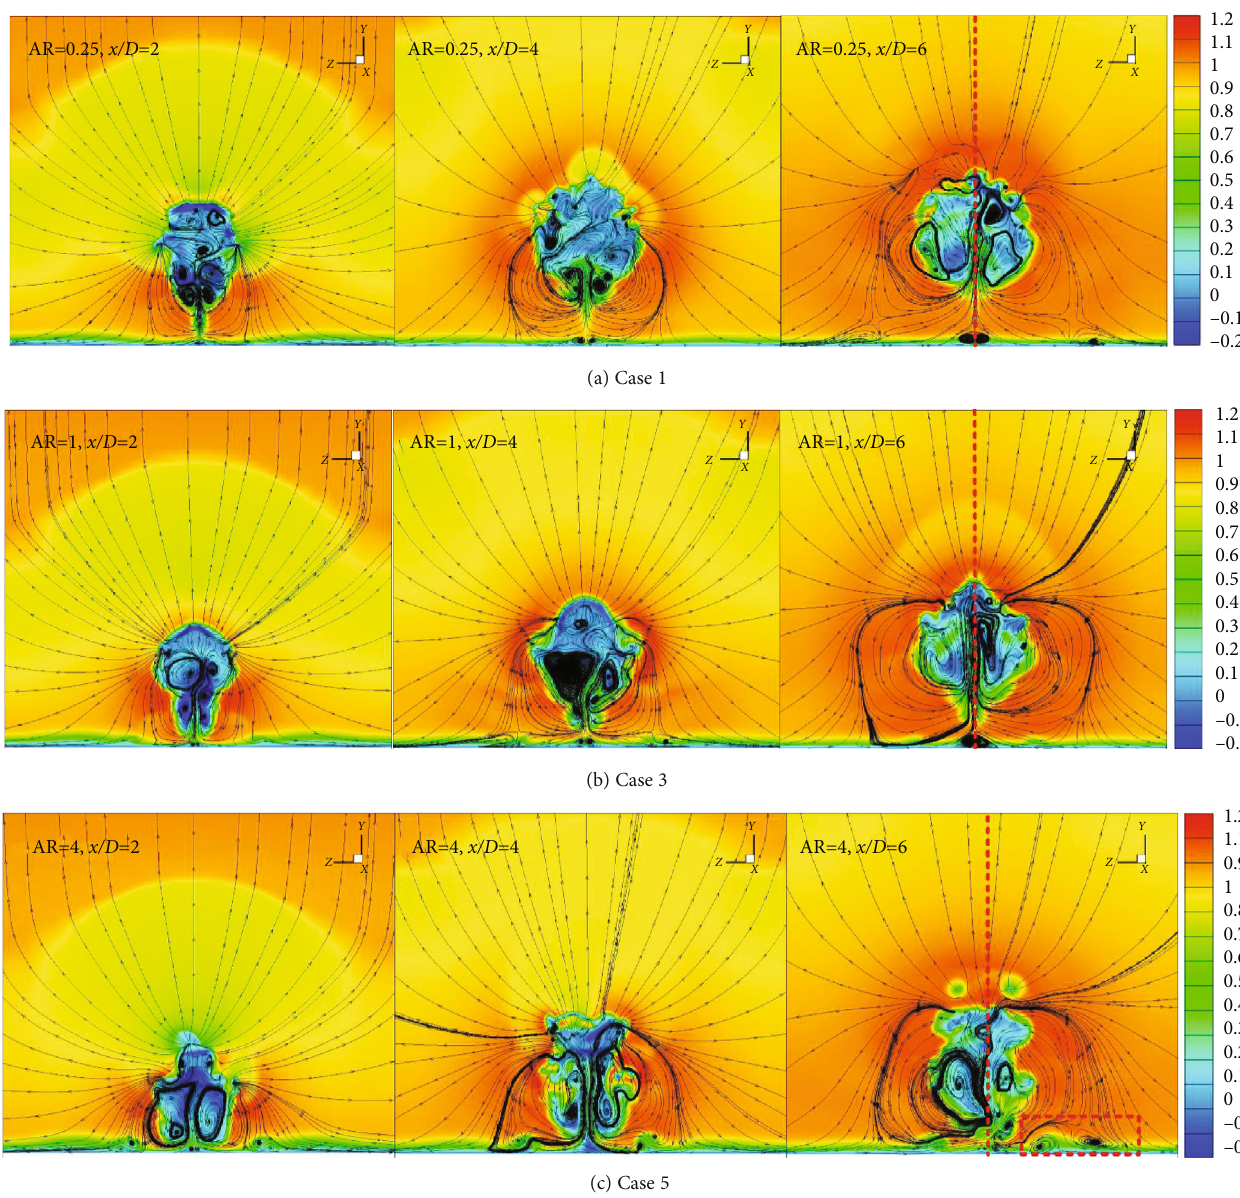
Figure 14: Streamlines with U ∗ contours in slice x / D = 2 , 4, and 6 for three AR, t = 56 : 4 μ